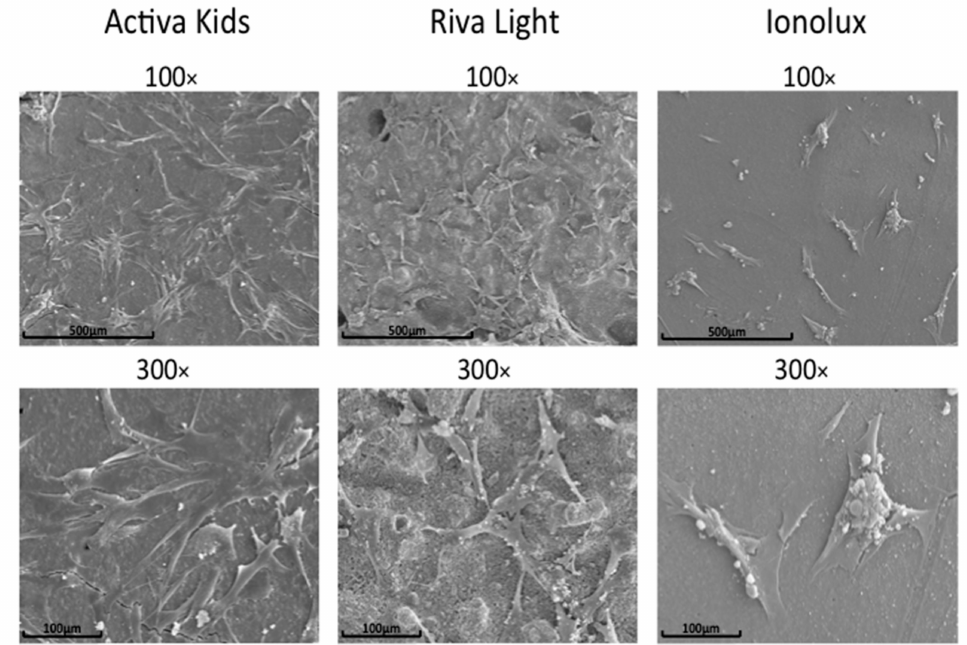
Figure 5. Cell attachment of hDPSCs on disks of Activa, Ionolux, and Riva at 72 h. Scale bar: 100 µ m and 500 µ